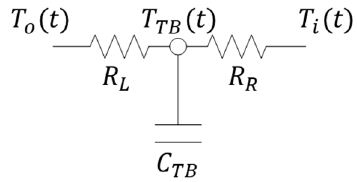
Figure A1. The 2R1C model.